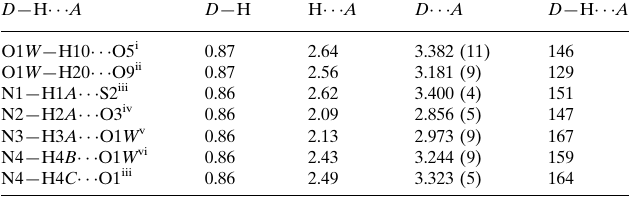
Hydrogen-bond geometry (A˚ , (cid:2)